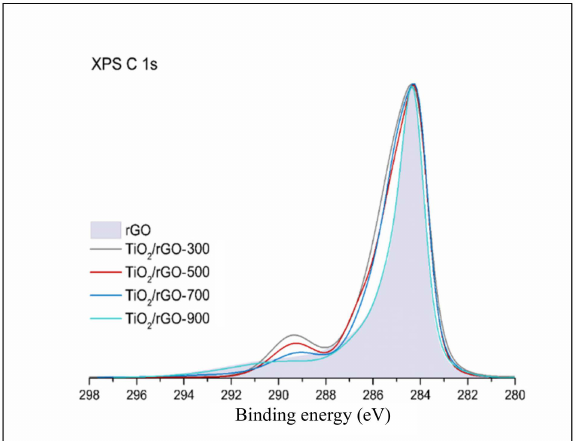
Figure 8. X-ray photoelectron spectra of C 1s transition for reduced graphene oxide (rGO) and selected TiO 2 and rGO hybrid